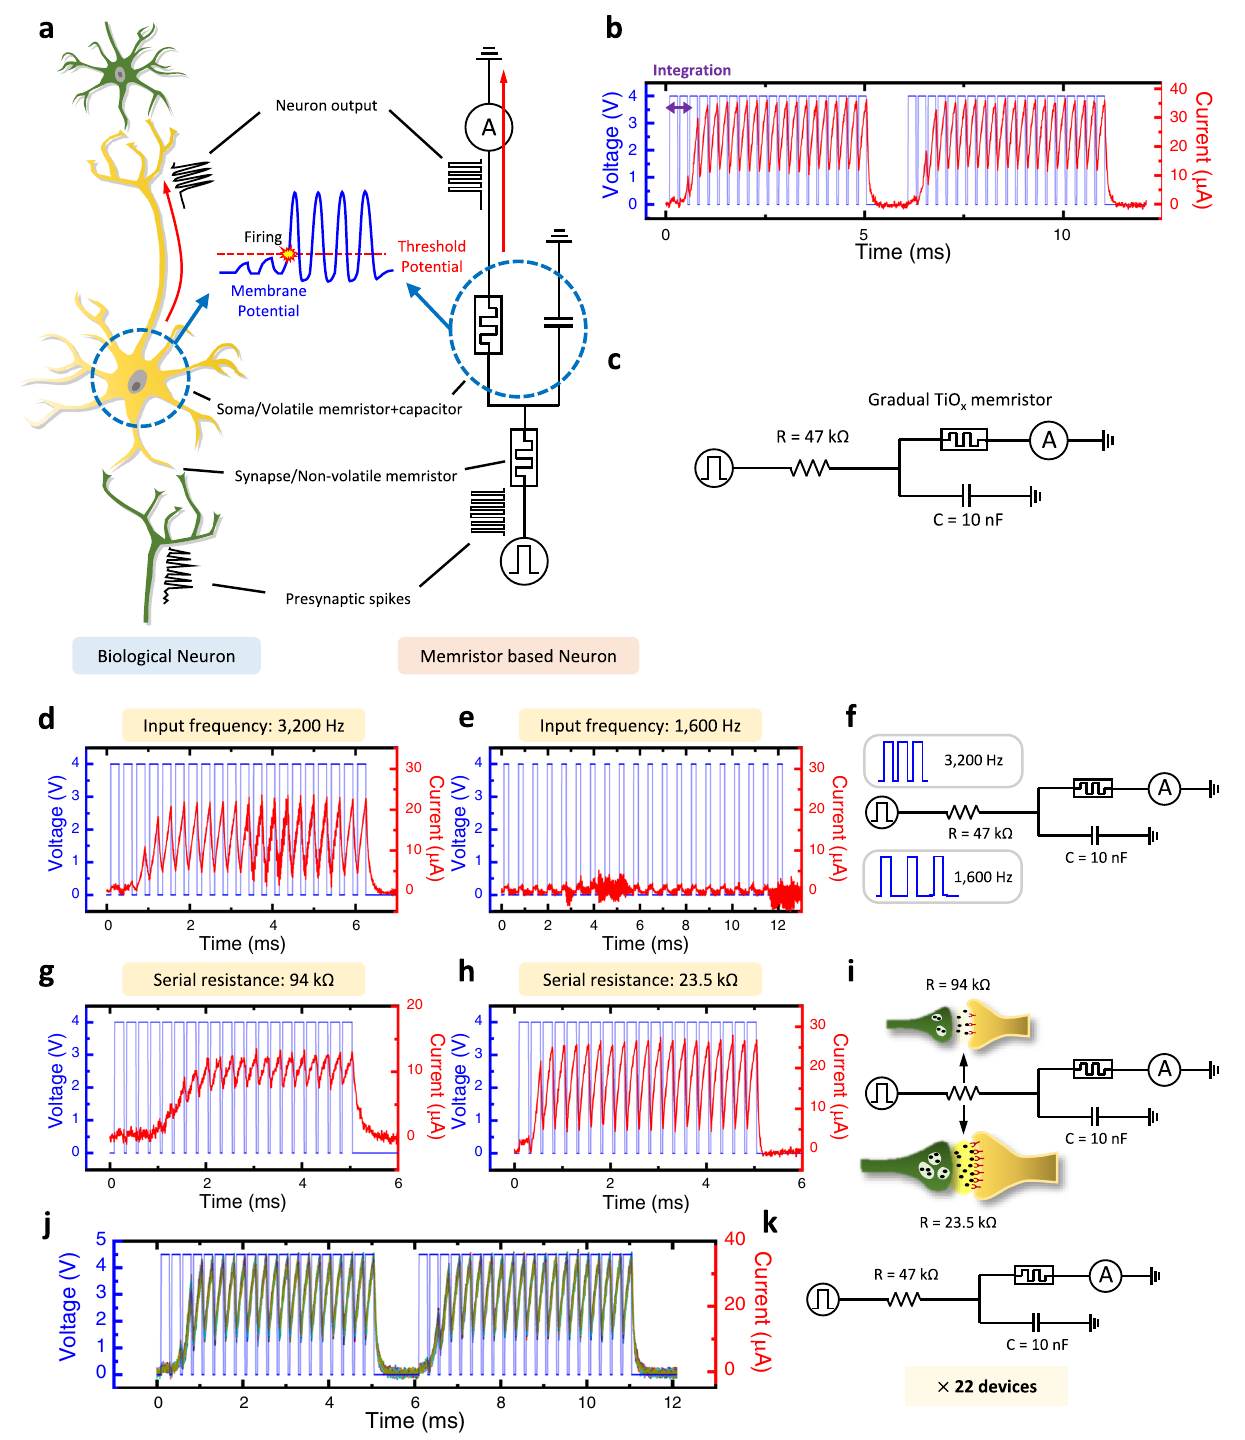
Fig. 3 Gradual TiO x memristor-based LIF neuron. a An illustration of a biological neuron and the analogous memristor-based arti fi cial LIF neuron. b The LIF neuron operation of the developed memristor-based arti fi cial neuron. Applied spike train condition: 4 V, 200 μ s width, and 50 μ s interval. c The schematic of the circuitry used for the gradual TiO x memristor-based arti fi cial neuron. d – f The output of the arti fi cial neuron along with different presynaptic spike frequencies (3200 Hz ( d ) and 1600 Hz ( e )), and the illustration of the experimental setup. During the test, the pulse amplitude and width are fi xed (4 V, 200 μ s). g – i The output of the arti fi cial neuron along with the different synaptic strengths (different resistors). When the synaptic strength is weak (large resistance ( g )), the arti fi cial neuron fi res within six spikes, while it requires fewer spikes when the synaptic strength is strong (small resistance ( h )). j , k The outputs of the 22 different arti fi cial neurons demonstrate low variation of the gradual TiO x memristor-based arti fi cial